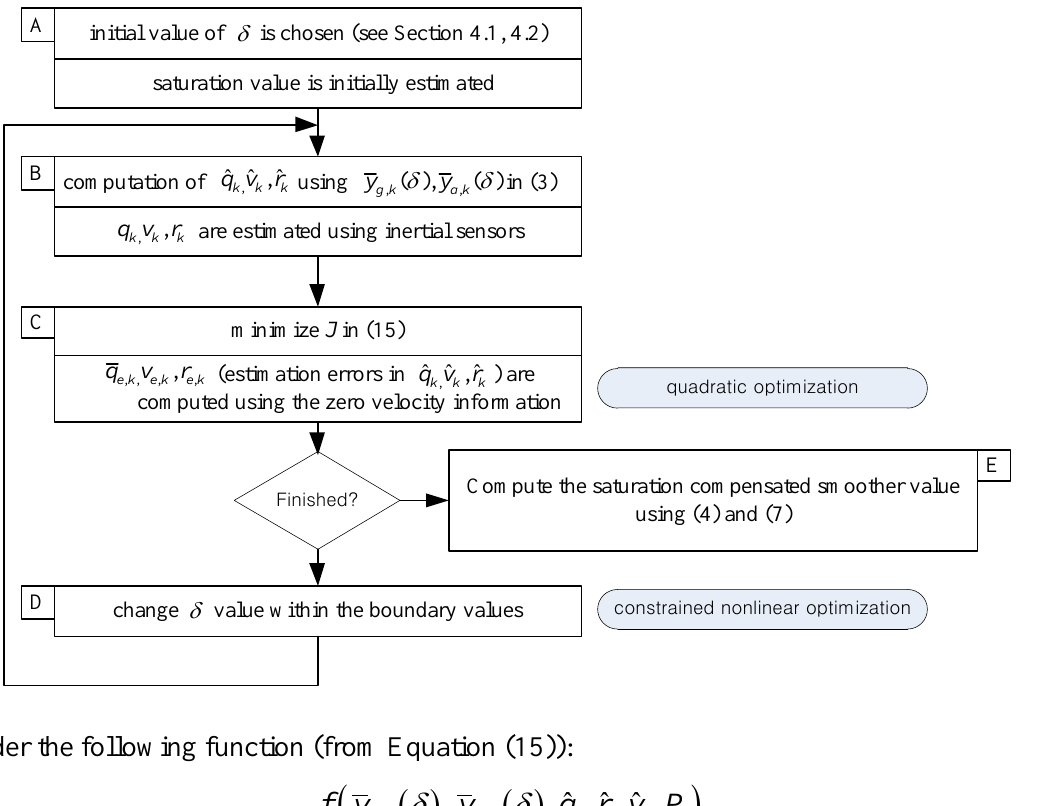
Figure 3. Proposed saturation compensated smoothing